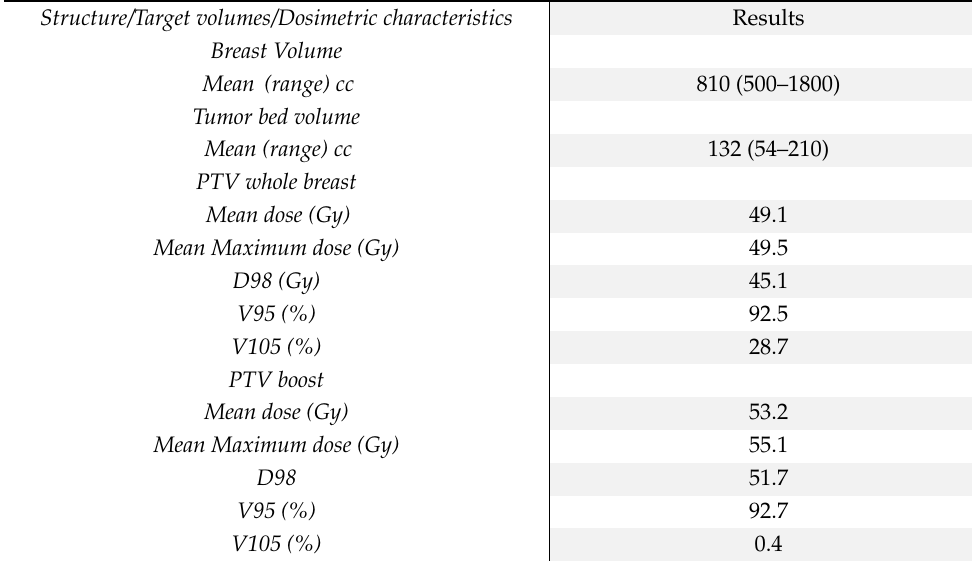
Table 2. Structure/target volumes and dosimetric